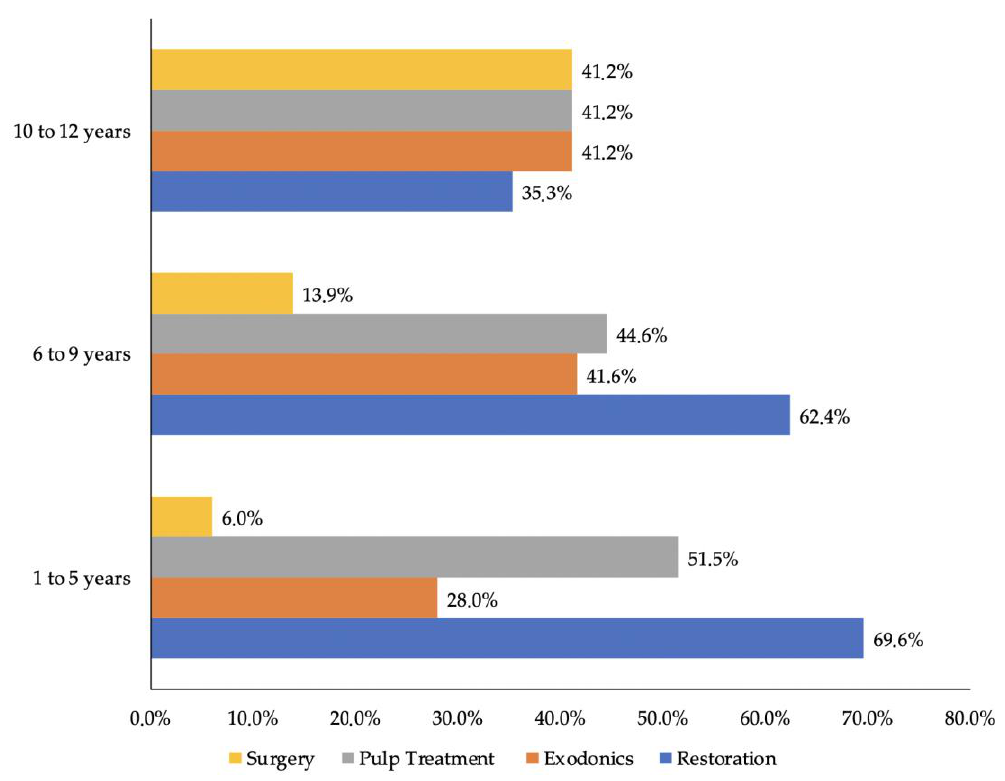
Figure 3. Type of dental procedure according to age group. Note: In the 1 to 5 year old and 6 to 9 year old groups, a higher percentage required sedation for restorations and pulp treatments.